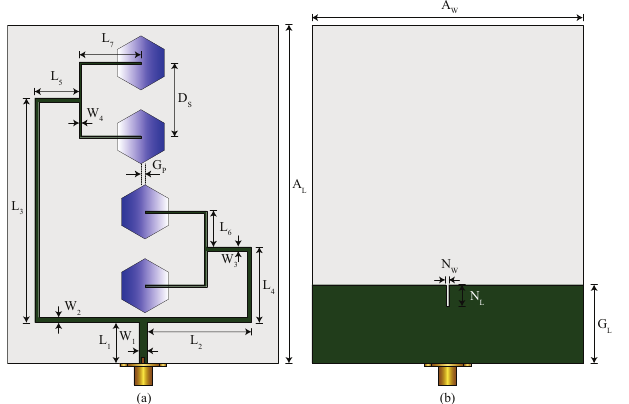
FIGURE 3: Proposed 4-element linear hexagonal DRA array: (a) Top view (b) Back-view. TABLE 2: Detailed dimensions of the proposed 4-element